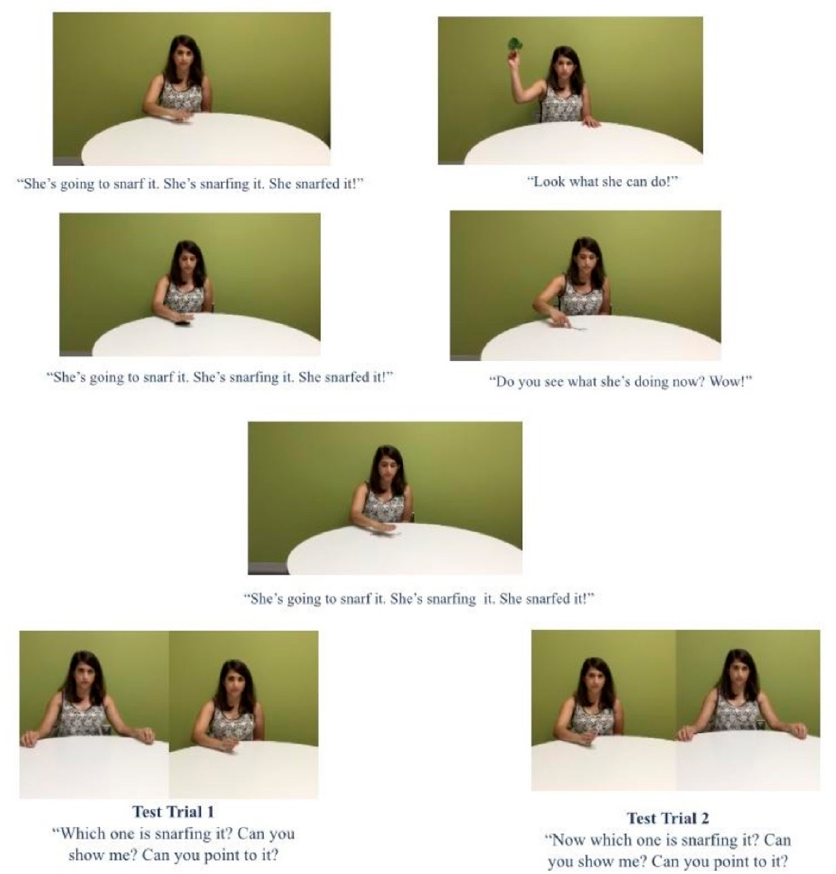
Figure 1. Example Stimuli. The top five photos show five events children saw during the learning phase in the study: Target ( upper left ), Distractor ( upper right ), Target ( middle left ), Distractor ( middle right ), and Target ( middle center ). The bottom two pairs of events show test trials with Test trial 1 ( left; correct extension right photo ) and Test trial 2 ( right; correct extension left photo